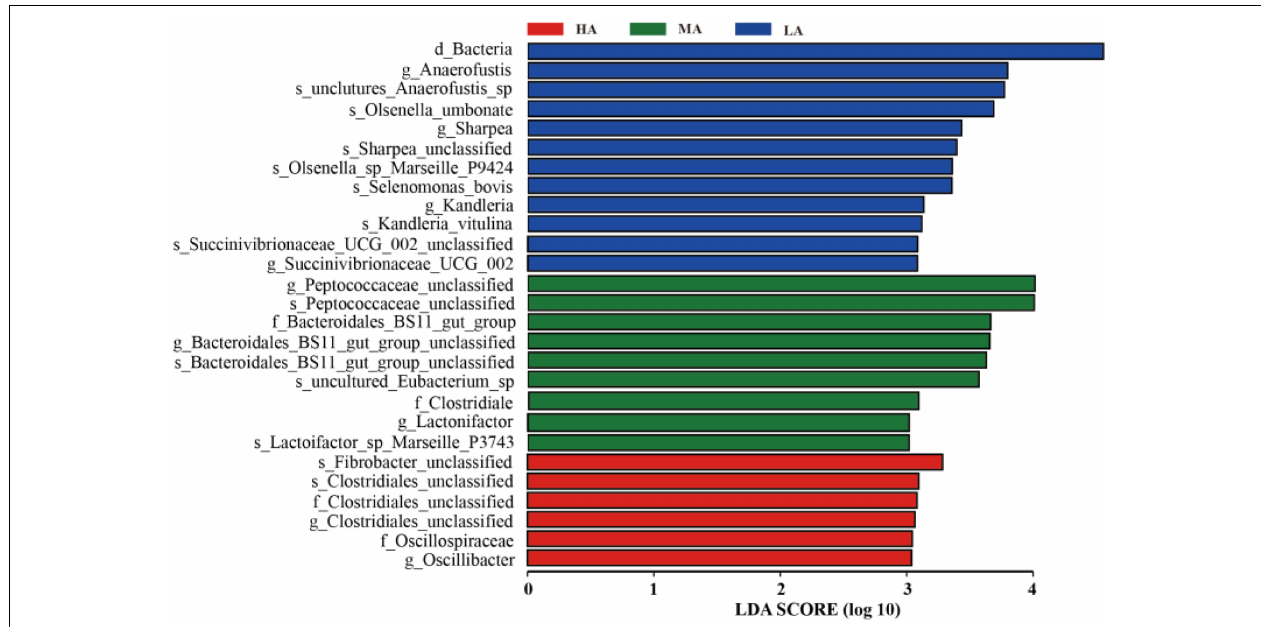
FIGURE 3 | Linear discrimination analysis (LDA) coupled with effect size (LEfSe) analysis of the rumen microbial community of lamb in the HA, MA, and LA groups. Significantly different species with an LDA score greater than the estimated value (default score = 3). The length of the histogram represents the LDA score of different species in the three groups. HA, high alfalfa percentages group; MA, middle alfalfa percentages group; LA, low alfalfa percentages